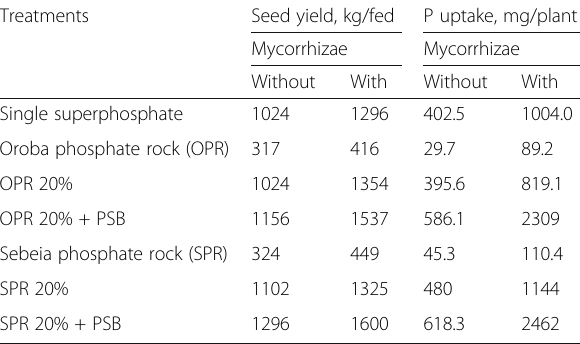
Table 4 Effect of PR with mycrrohizae on soybean seed yield and P uptake Treatments Seed yield, kg/fed P uptake, mg/plant Mycorrhizae Mycorrhizae Without With Without With Single superphosphate 1024 1004.0 Oroba phosphate rock (OPR)